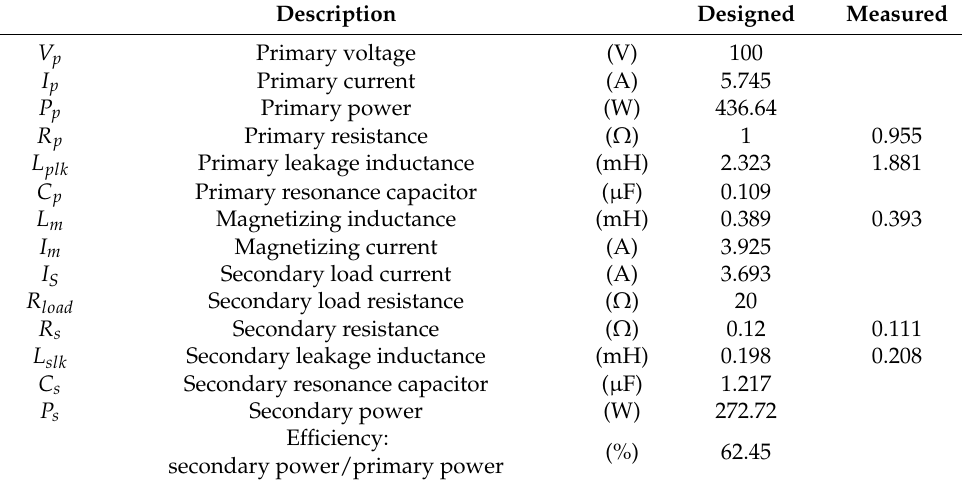
Table 6. Designed and measured value of wireless power transfer device.